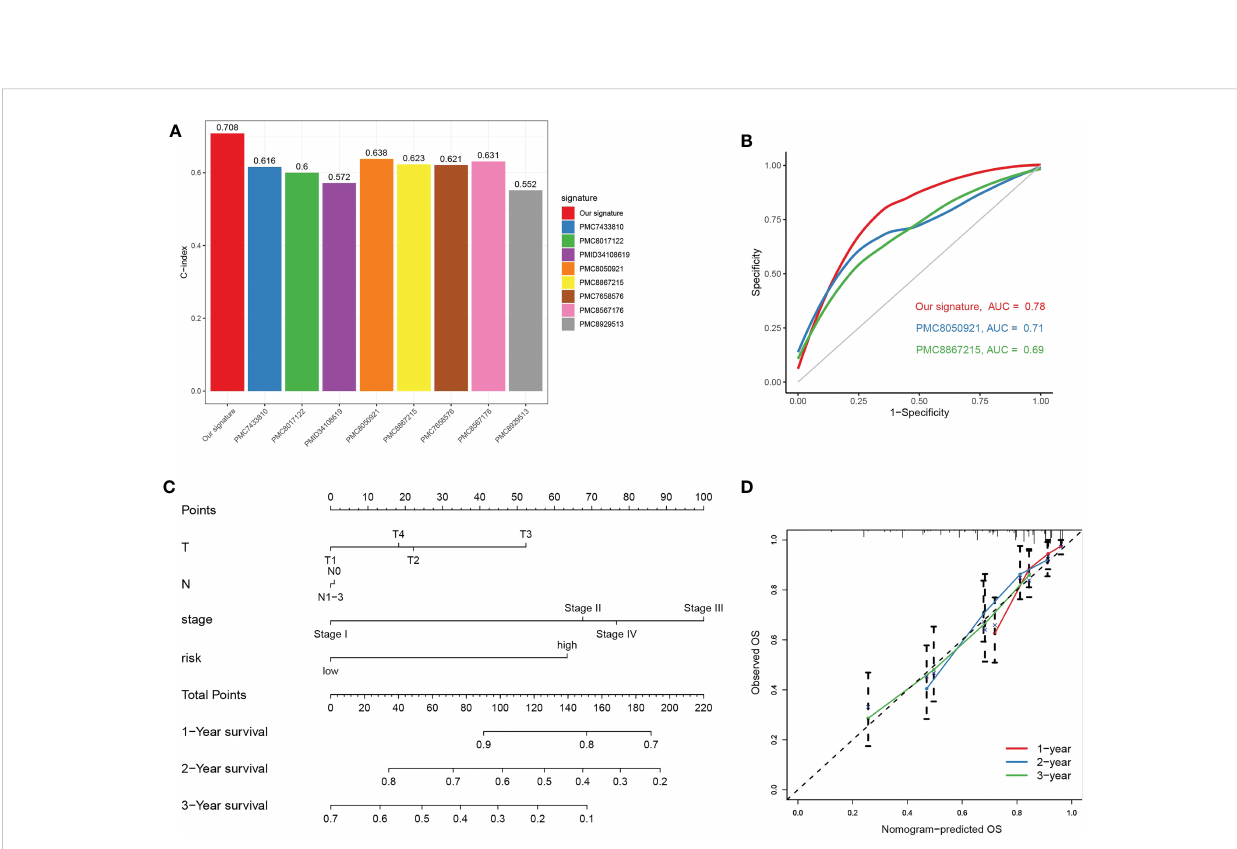
FIGURE 9 Prognostic nomogram combing key clinical features. (A) Comparison of C-Index between our TPRGs risk model and a few published models (including PMC7433810, PMC8017122, PMID34108619, PMC8050921, PMC8867215, PMC7658576, PMC8567176 and PMC8929513). (B) Receiver operating characteristic curves for 1-year using our risk model and two other published models (PMC8050921 and PMC8867215). (C) A nomogram combining T, N, stage and risk score predicts 1-, 3-, and 5-years survival. (D) Calibration curves test the agreement between observed and predicted overall survival at 1-, 3-, and